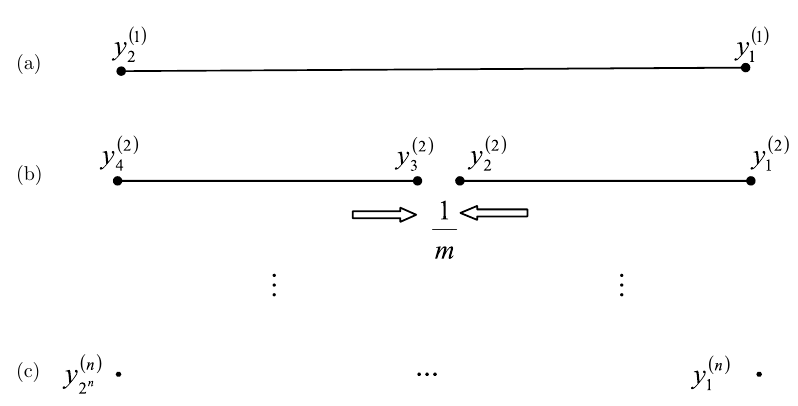
ð m > 1 Þ is de¯ned by repeatedly removing Fig. 1. The fractal curve with the dimension ! ð m Þ ¼ ln 2 ln 2 þ ln m m (cid:1) 1 the middle 1 m of line segments: (a) One starts by removing the middle 1 m from the interval ½ y ð 1 Þ 2 ; y ð 1 Þ 1 (cid:3) , leaving ½ y ð 2 Þ ; y ð 2 Þ (cid:3) and ½ y ð 2 Þ ; y ð 2 Þ (cid:3) . (b) Next, the \middle 1 3 2 1 4 m " of all remaining intervals is removed. (c) This process is continued ad in¯nitum . Finally, the ! ð m Þ -dimensional fractal curve consists of all points in the